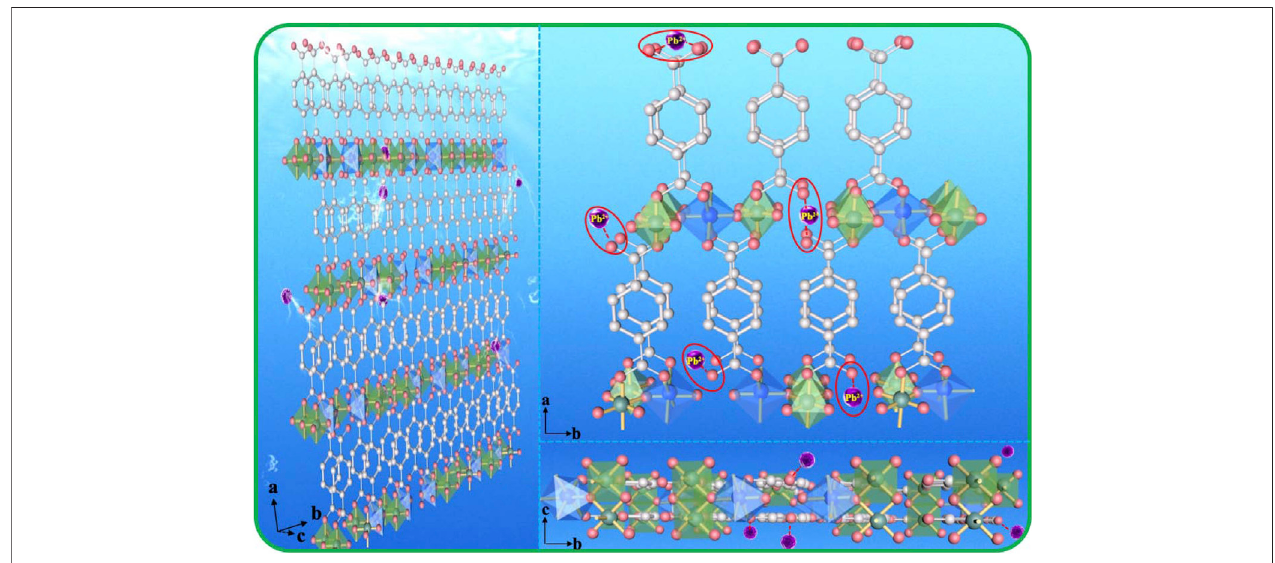
FIGURE 10 | Schematic diagram of 2D MOFs for Pb 2+ removal in aqueous